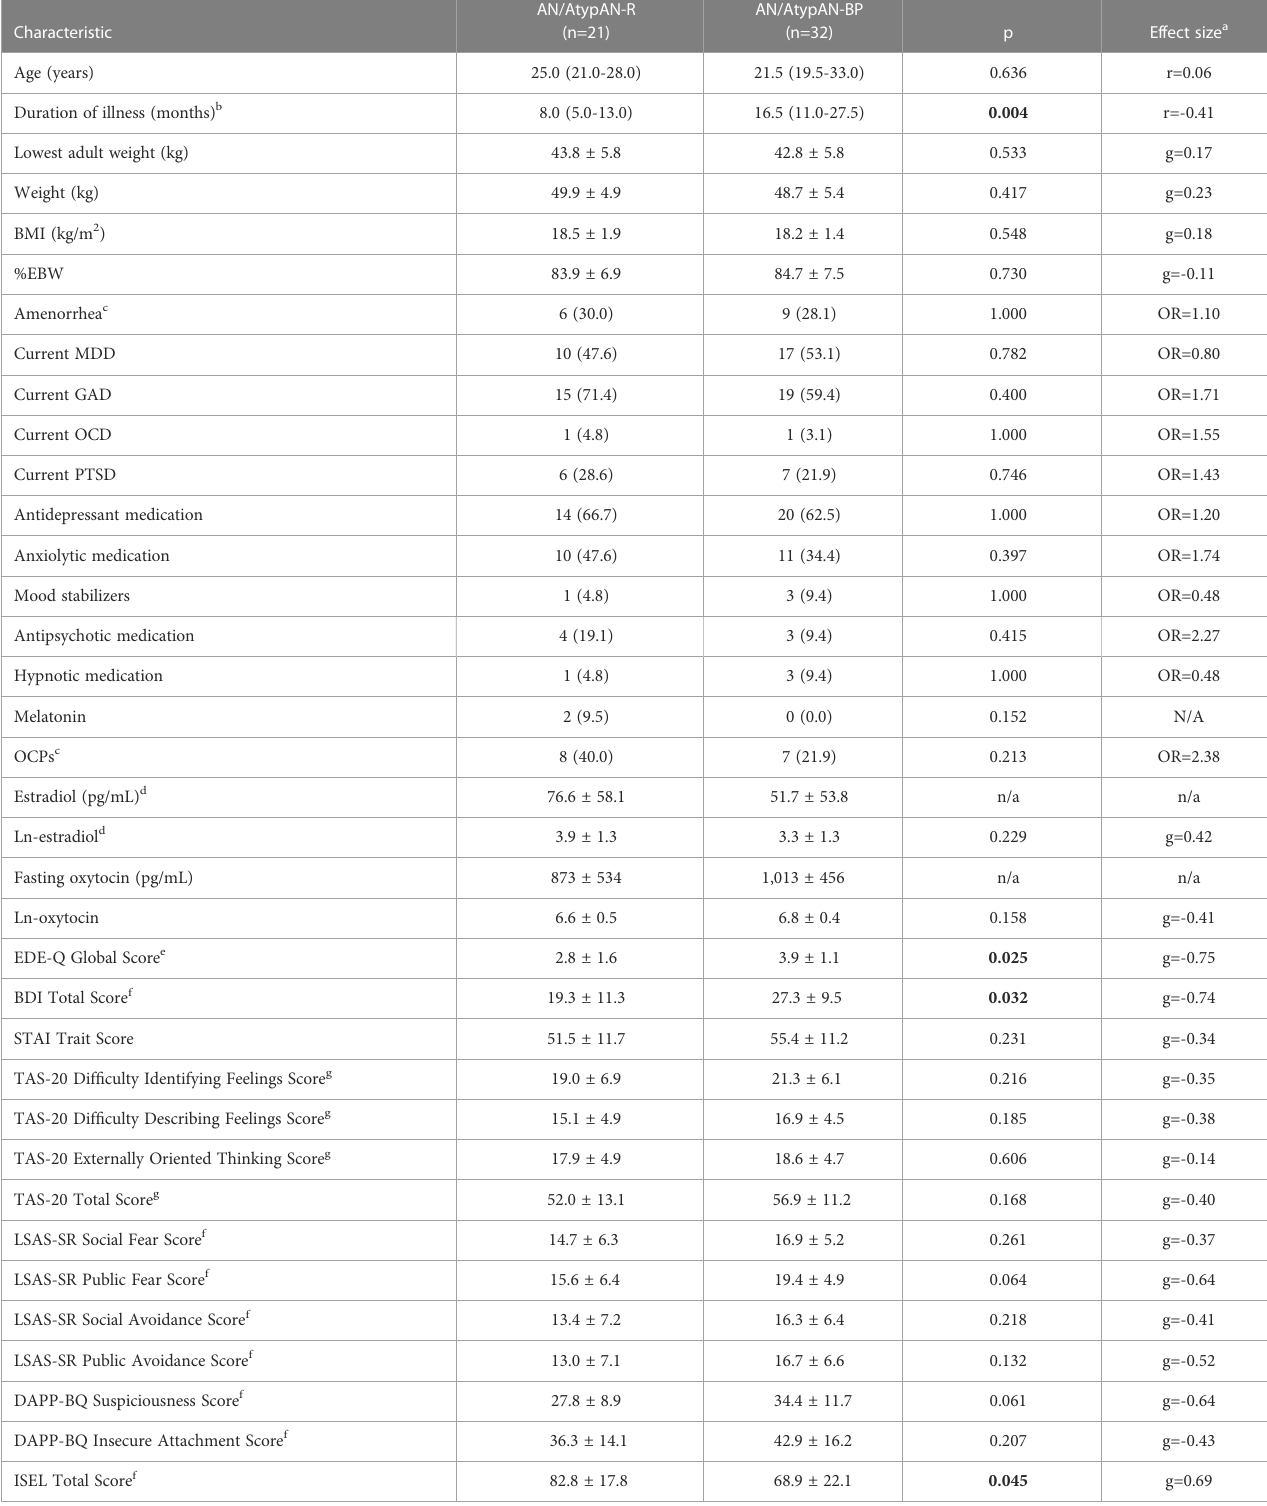
TABLE 2 Participant characteristics for women with anorexia nervosa (AN)/Atypical AN who are solely restricting (AN/AtypAN-R) versus those who restrict in combination with binge/purge behaviors (AN/AtypAN-BP).